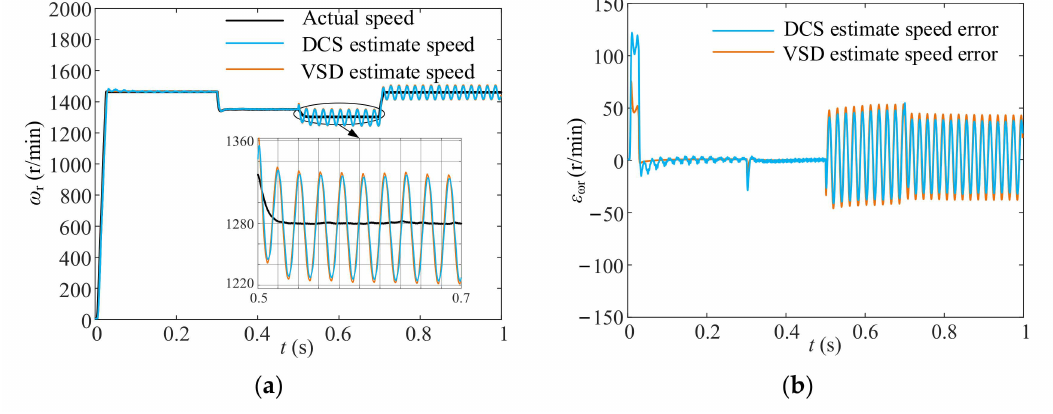
Figure 18. Speed-estimation results without stator resistance identification. ( a ) Speed; ( b ) Speed